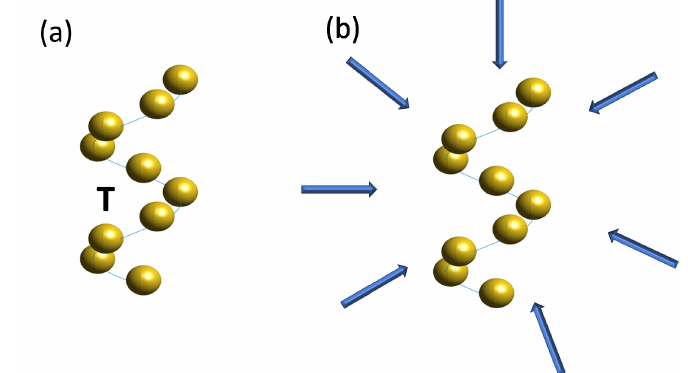
Figure 1. Illustration of the difference between ( a ) T-matrix extraction procedure and ( b ) averaging procedure. Here, the averaging procedure is done using several plane waves with different direction of propagation. The considered meta-atom consists of a helical arrangement of gold nanoparticles with a radius of 80 nm arranged in a helix. The helix has a total height 1200 nm and a radius 200 nm. The helix consist of 2 pitches.